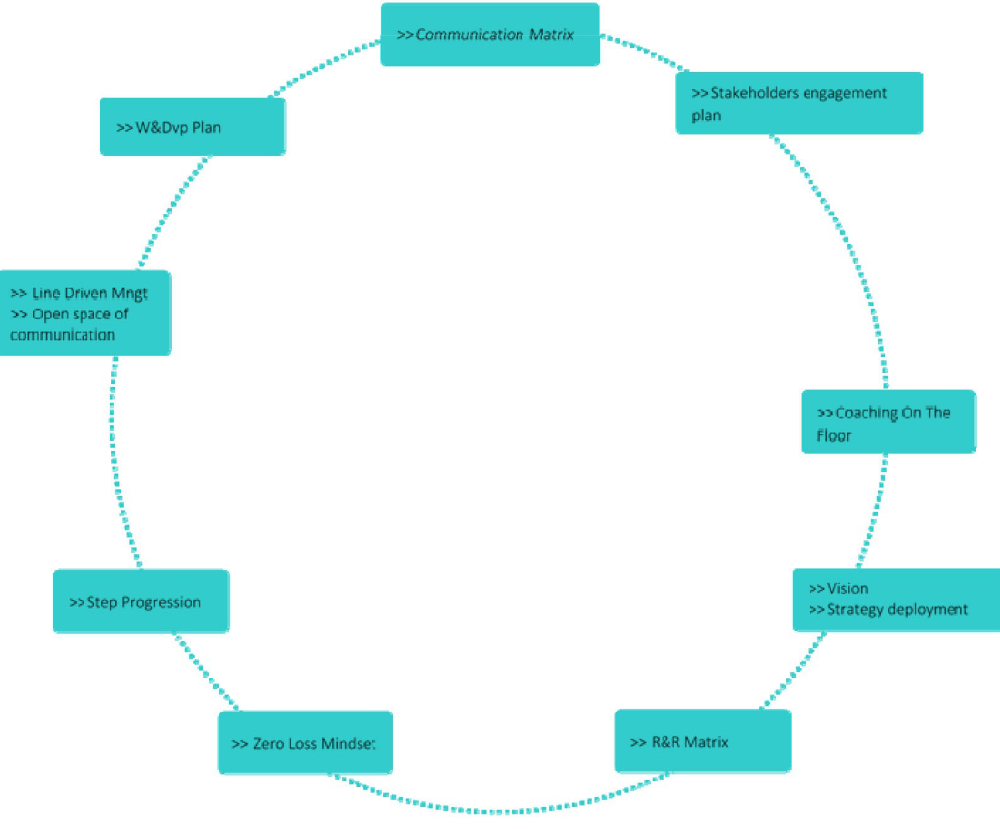
Figure 14. Working Tools layer